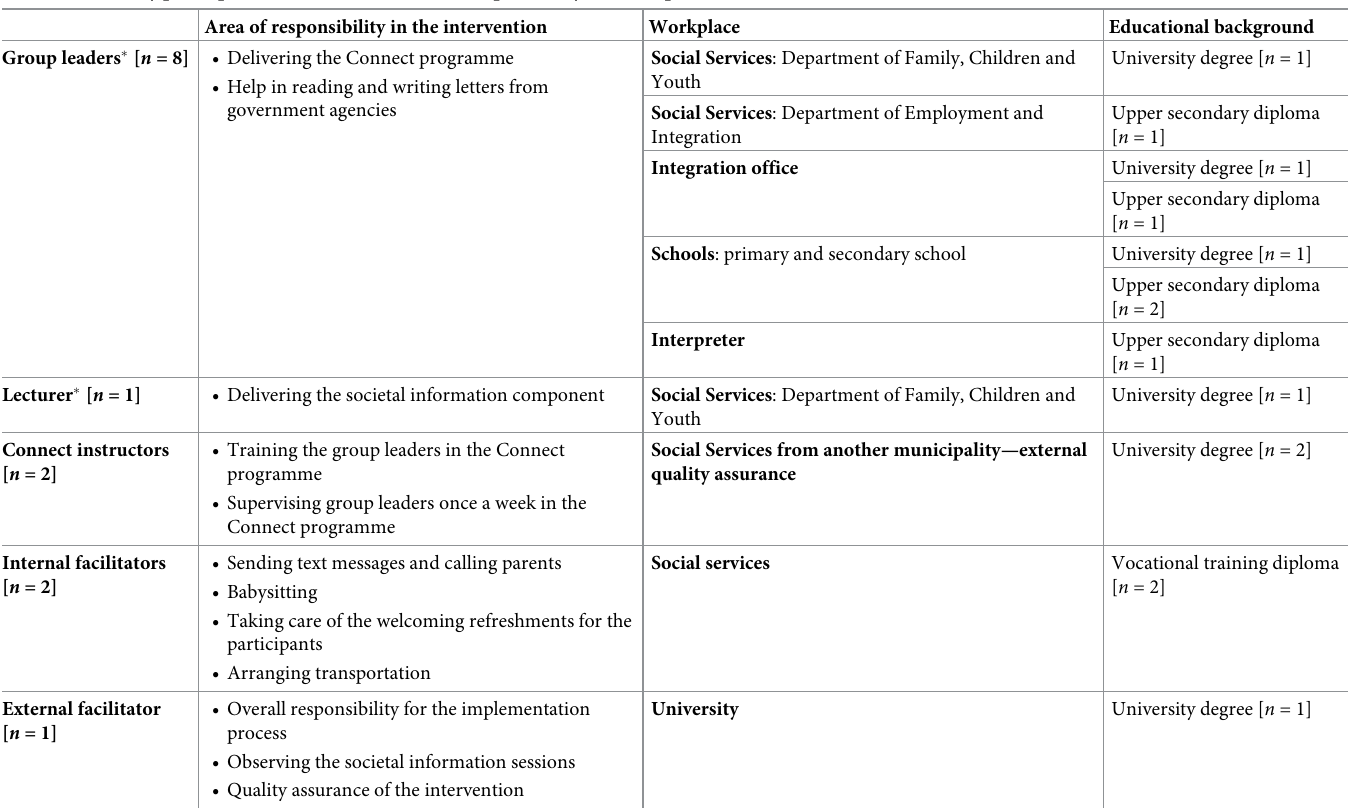
Table 2. The study participants’ characteristics, areas of responsibility and